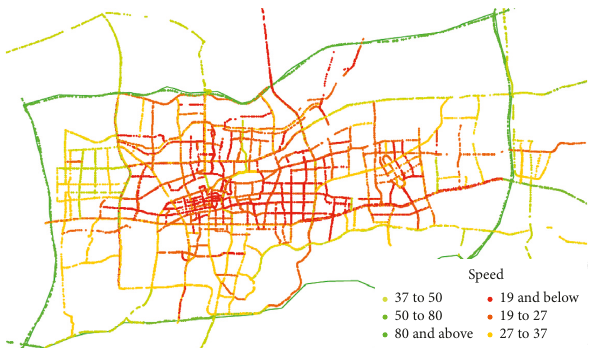
Figure 9: Speed distribution for the study